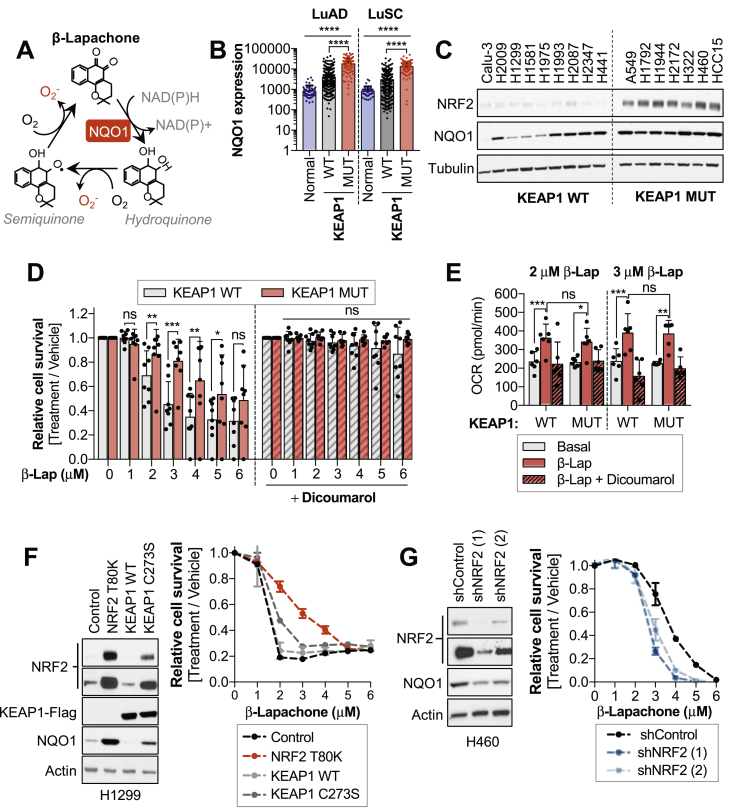
Aberrant activation of NRF2 increases resistance to β-Lapachone treatment.*Please note that, for survival assays, cells were exposed to β-lapachone for 2 h, after which medium was replaced and cell viability was assessed 48 h after treatment using CellTiter-Glo (D) or crystal violet staining (F,G). Western blots included in Fig. 1C, S3B and S4E are a reprobing of the same blot and share the loading control (tubulin).(A) Schematic representation of β-lapachone redox cycling. NQO1 catalyzes the two-electron reduction of β-lapachone to a hydroquinone form, which can spontaneously reoxidize, leading to the formation of superoxide radicals. (B) NQO1 mRNA expression in healthy lung tissue, lung adenocarcinomas (LuAD) and lung squamous cell carcinoma (LuSC). NQO1 mRNA expression in tumors was subdivided according to the KEAP1/NRF2 mutational status. One-way ANOVA statistical test was performed to compare groups. LuAD: P-value ANOVA summary <0.0001; Tukey's multiple comparison test Normal Vs WT (0.004, **) Normal vs MUT (<0.0001, ****). LuSC: P-value ANOVA summary <0.0001; Tukey's multiple comparison test Normal Vs WT (0.0212, *) Normal vs MUT (<0.0001, ****). (C) Western blot analyses of NRF2, NQO1 and Tubulin expression in a panel of wild-type (WT) and mutant (MUT) KEAP1 NSCLC cells. Note that Calu-3 cells harbor a polymorphic variant of NQO1 (NQO1*3, 465C < T). (D) Survival assays of KEAP1 wild-type (WT) and KEAP1 mutant (MUT) NSCLC cell lines exposed to β-lapachone alone (left) or in combination with the NQO1 inhibitor dicoumarol (right). Cells were treated with vehicle (<0.1% DMSO) or the indicated concentrations of β-lapachone alone or in combination with dicoumarol (50 μM). KEAP1WT cells: H2009, H1299, H1581, H1975, H1993, H2087, H2347 and H441. KEAP1MUT cells: A549, H460, H1792, H2127, H1944, HCC15, H322. Data presented as mean ± S.D. P-values KEAP1 WT vs MUT β-lap 2 μM = 0.0081 (**), 3 μM = 0.0002 (***), 4 μM = 0.0014 (**), 5 μM = 0.0314 (*) were calculated using unpaired t-tests. (E) Oxygen consumption rates of a panel of KEAP1 WT and MUT NSCLC cells exposed to 2 and 3 μM of β-lapachone alone or in combination with 50 μM of dicoumarol for 117 min. KEAP1WT cells: H1299, H1581, H1975, H441, H2347, H2087. KEAP1MUT cells: A549, H2172, H1944, H460, HCC15, H1792. Data presented as mean ± S.D. P-values KEAP1WT basal vs β-lapachone 2 μM (0.0007, ***) and 3 μM (0.0006, ***) and KEAP1MUT basal vs β-lapachone 2 μM (0.0179, *) and 3 μM (0.0029, **) were calculated using a paired t-test statistical analysis. (F) H1299 cells (KEAP1 WT) were infected with an empty vector (Control) or a virus coding for the expression of NRF2 T80K, KEAP1 wild-type or KEAP1 C273S. Left, Western blot analyses of NRF2, Flag (for KEAP1 detection), NQO1 and actin (loading control). Right, survival assays of cells exposed to β-lapachone. (G) Western blot (left) and survival assays (right) of H460 (KEAP1 MUT) infected with virus coding for shRNAs against NRF2 (shNRF2) or an shRNA control.